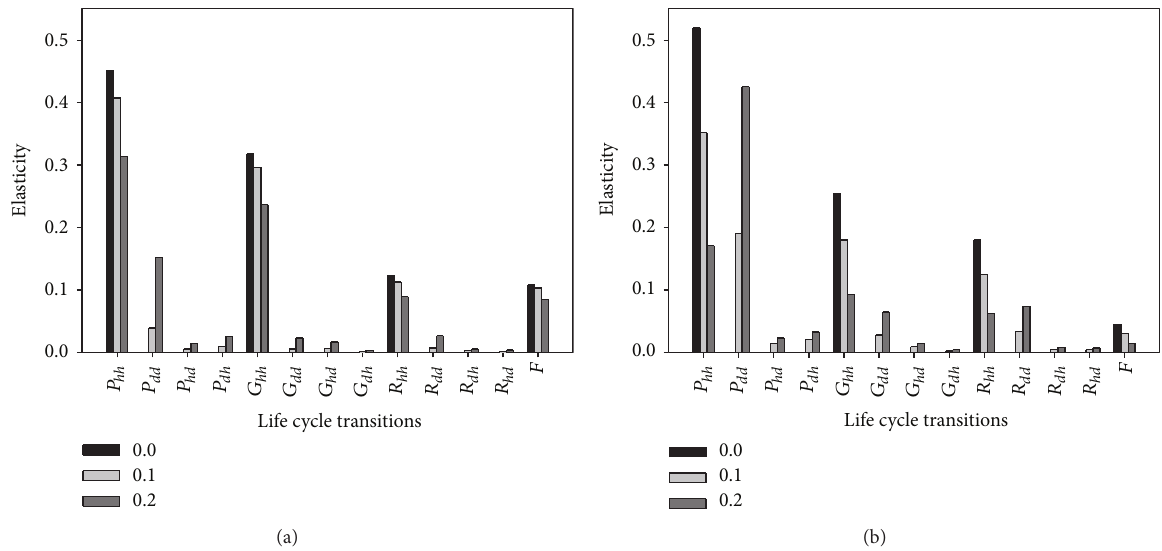
Figure 3: Elasticity of life cycle transitions of Gorgonia ventalina for three levels of disease incidence (0, 0.10, and 0.20) under (a) high and (b) low recruitment.